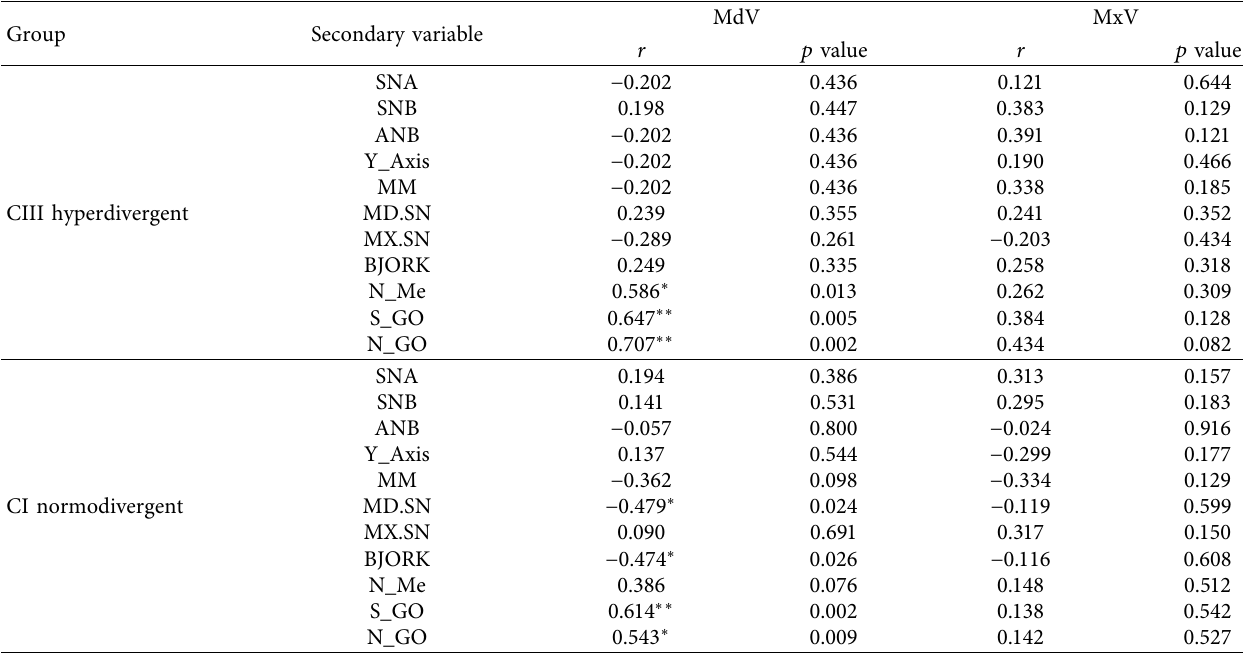
Table 6: Values of correlation coefficients between 2D variables and the volumetric measurements in CIII hyperdivergent and CI normodivergent